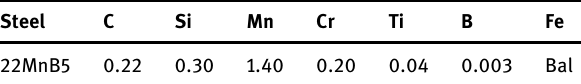
Table 1: Chemical components of 22MnB5 ( wt% )